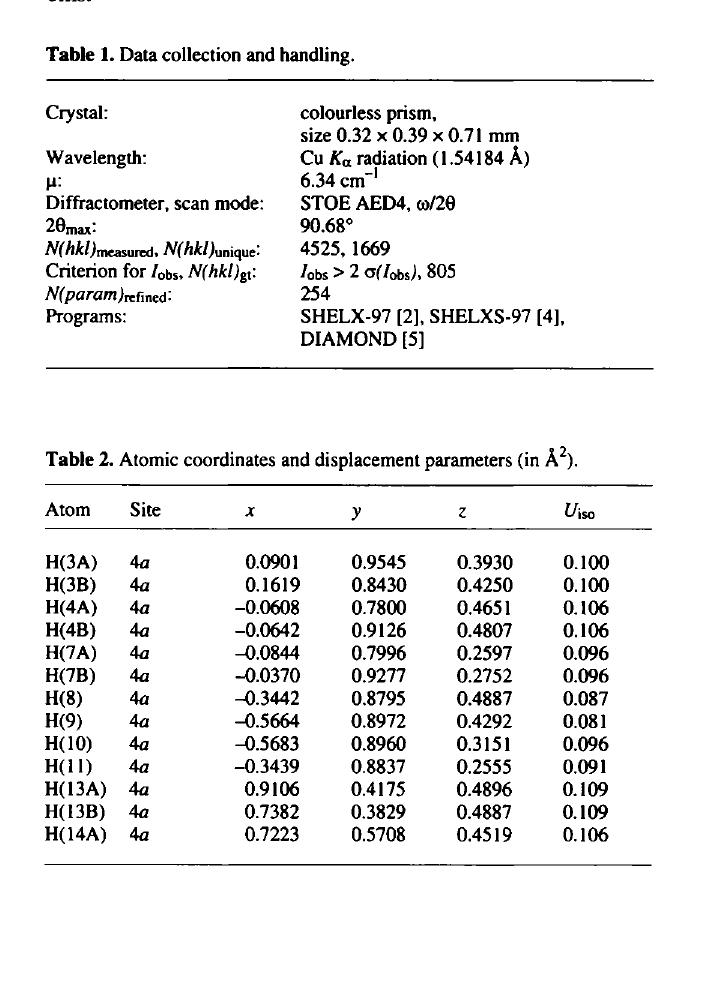
Table 1. Data collection and handling.